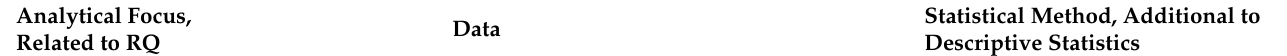
Table 2. Overview of research questions A–D on the occurrence and abundance of bird species across four foci of analysis, related data sources, and the statistical methods